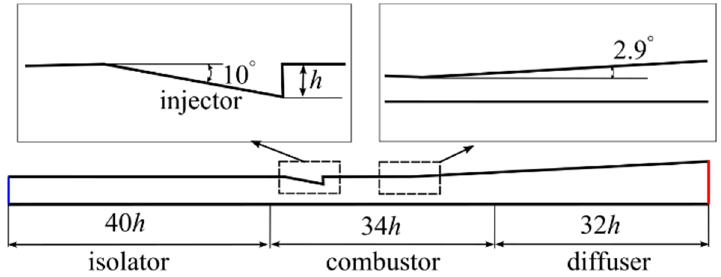
Figure 4. Schematic representation of the experimental model. Table 2. Flow Properties at the entrance of combustor after mass-weighted